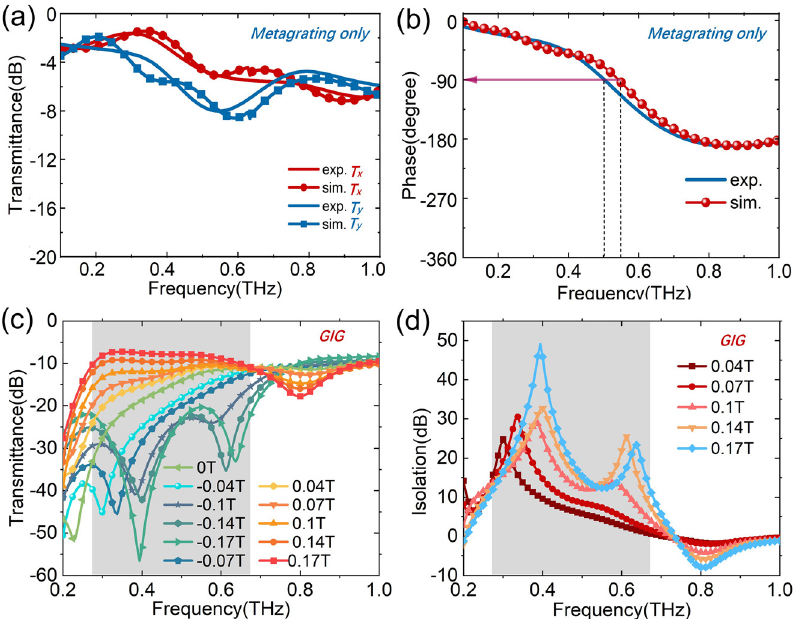
Figure 3: The simulative and experimental transmission spectra of the meta-grating on the Si substrate of x -LP (along with the minor axis) and y -LP (along with the long axis of grating); (b) the simulative and experimental phase difference of the grating between two orthogonal x -LP and y - LP. (c) The experimental transmission spectra from LP input to LP output of the GIG device under different MFs; (b) isola- tion of the GIG under different